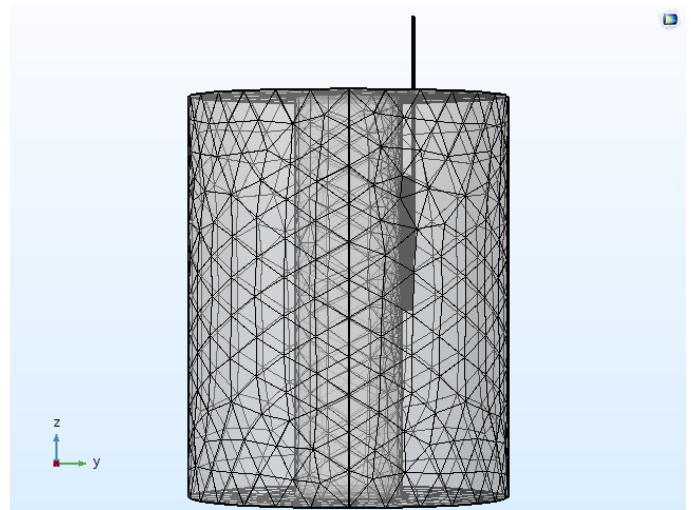
Figure 2. Meshed computational domain of the continuous RF procedure comprising of 174,486 tetrahedral elements. tetrahedral